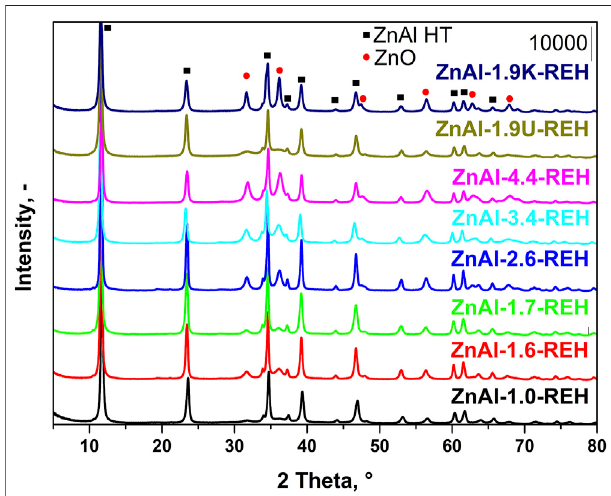
FIGURE 1 | XRD patterns of reconstructed LDHs: ZnAl-X-REH with Zn/ Al molar ratio 1.0 – 4.4, ZnAl-1.9K-REH and ZnAl-1.9U-REH.